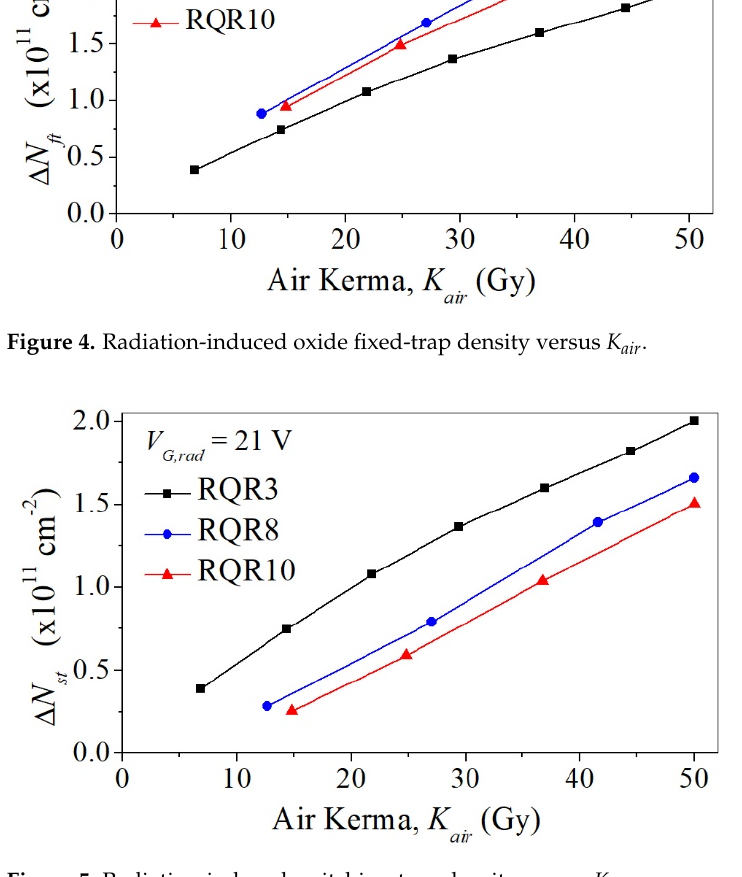
Figure 5. Radiation-induced switching-trap density versus K air .